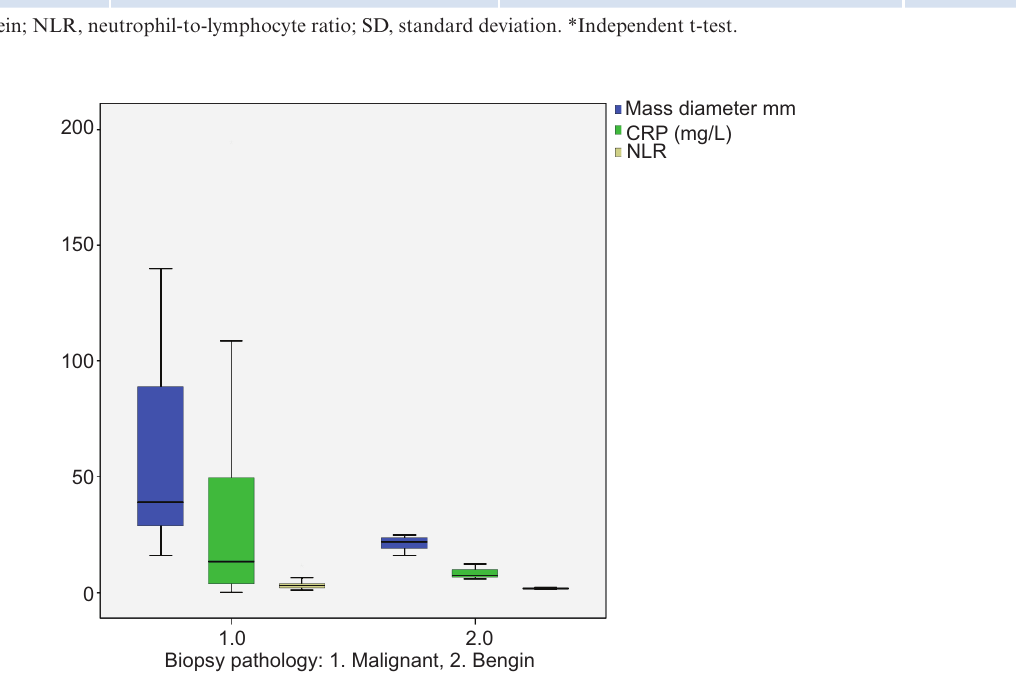
Figure 1: Levels of the parameters and tumor diameter between the groups within the graph. Table 3: Sensitivity and specificity of C-reactive protein in predicting the malign pathology after renal mass biopsy.